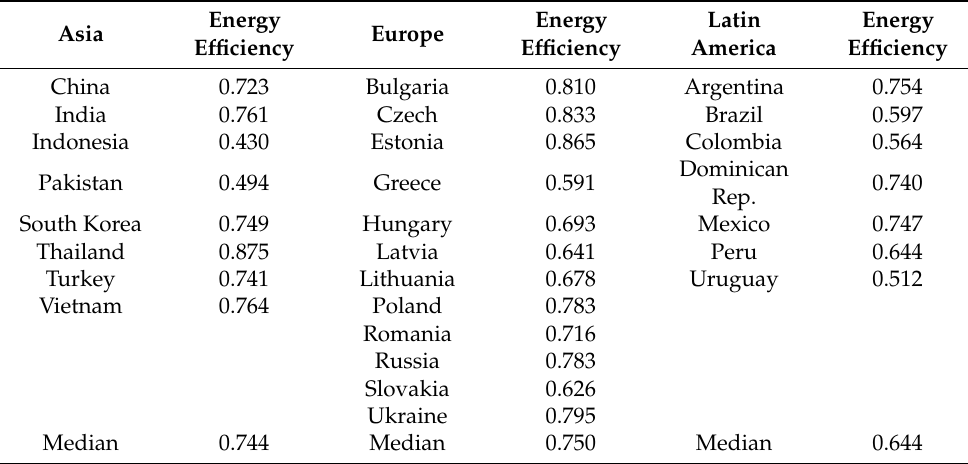
Table 2. Energy efficiency in the agricultural sector of emerging economies (1998–2017).